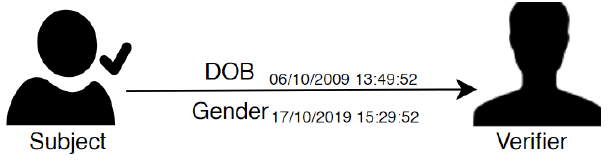
Figure 3: Subject revealing verification claims about their identity to a verifier. The timestamp of the claim can reveal a gender change to the verifier as it is obvious that gender change has a later verification from DOB. DOB may also have several more claims then gender.